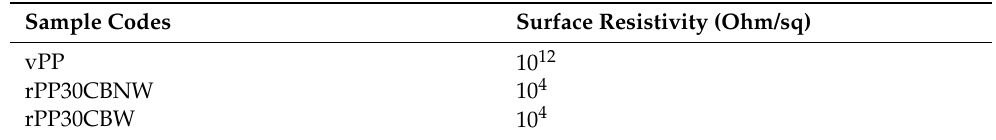
Table 3. The surface resistivity of vPP, rPP30CBNW and rPP30CBW